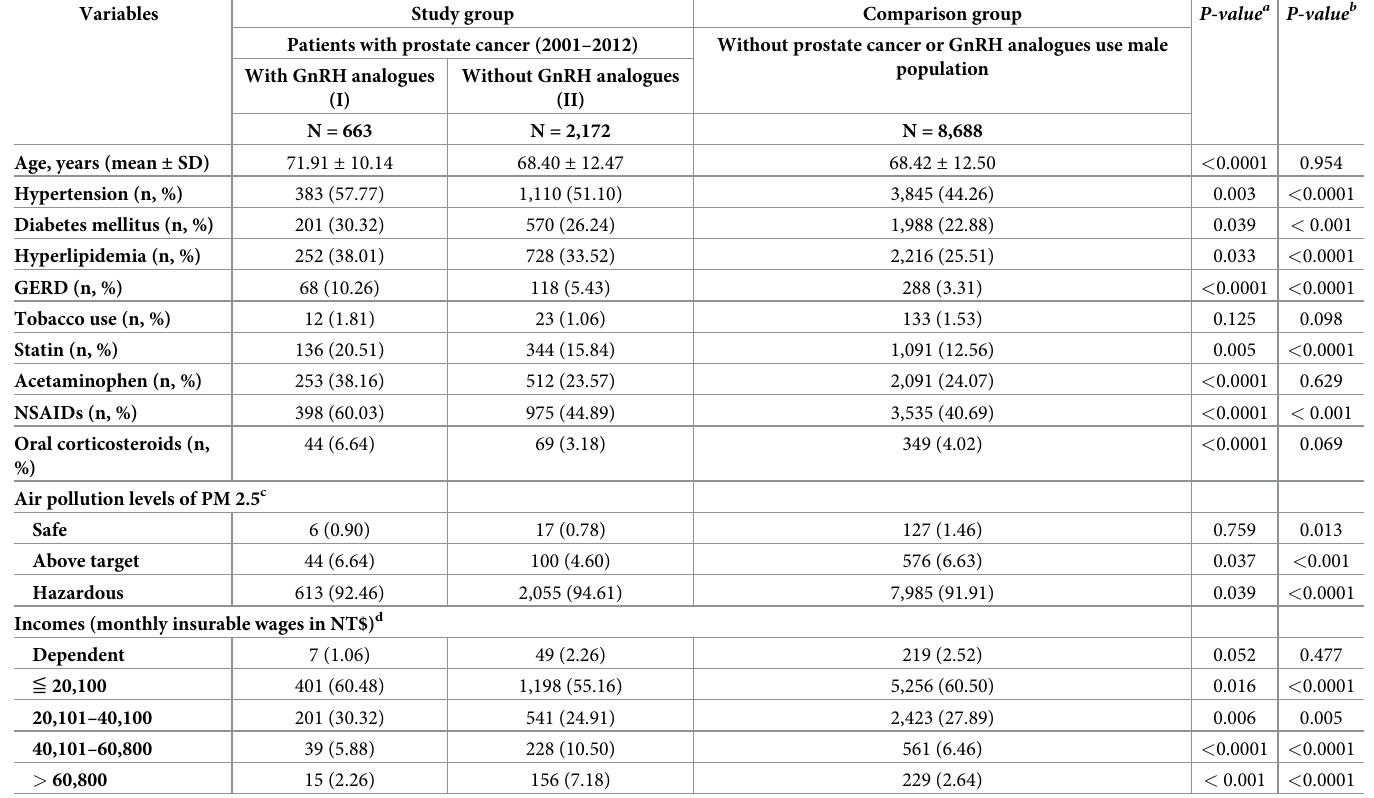
Table 1. Baseline characteristics of patients with prostate cancer and matched cohort.